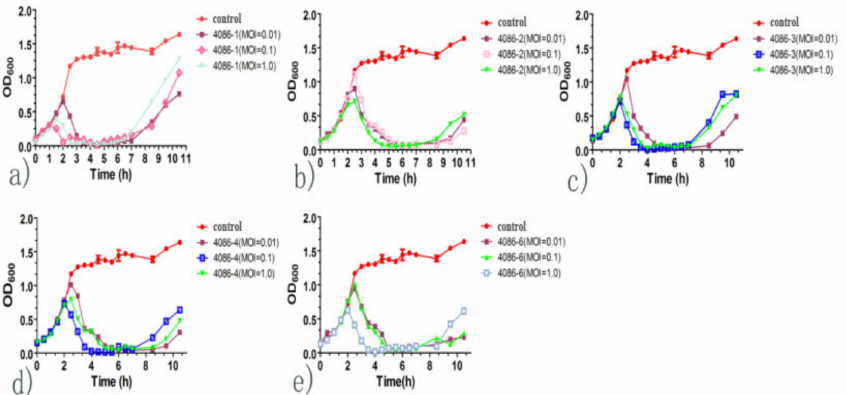
Figure 6. Effect of the isolated phages on bacterial growth. Host bacteria S. aureus CVCC 546 were infected with phage 4086-1, phage 4086-2, phage 4086-3, phage 4086-4, and phage 4086-6 to determine the OD600 at different times. Phages could effectively inhibit the growth of S. aureus CVCC 546 when the MOI was 0.01, 0.1, 1, and 10. ( a ) Phage 4086-1; ( b ) Phage 4086-2; ( c ) Phage 4086-3; ( d ) Phage 4086-4; ( e ) Phage